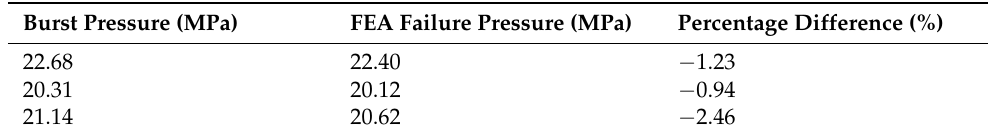
Table 8. FEM validation against full scale burst tests by Benjamin et al.